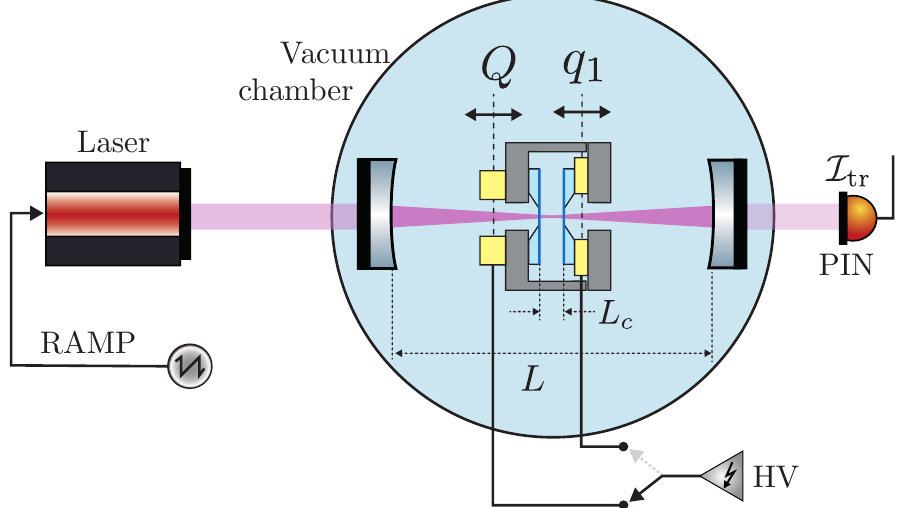
Figure 2. Experimental setup for the measurements reported in Figure 3. The light of a laser at 1064 nm wavelength transmitted by an optical cavity of length L = 90 mm containing the membrane sandwich of thickness L m = 104 nm, and distance L c = 24 µ m at rest, is revealed by a PIN photodiode ( I N tr ), while the frequency is scanned by applying a ramp signal (RAMP) to the piezo control of the laser. The positions of the two membranes are controlled by applying high-voltage (HV) to the piezos, which move the CoM, Q , and the cavity length, q 1